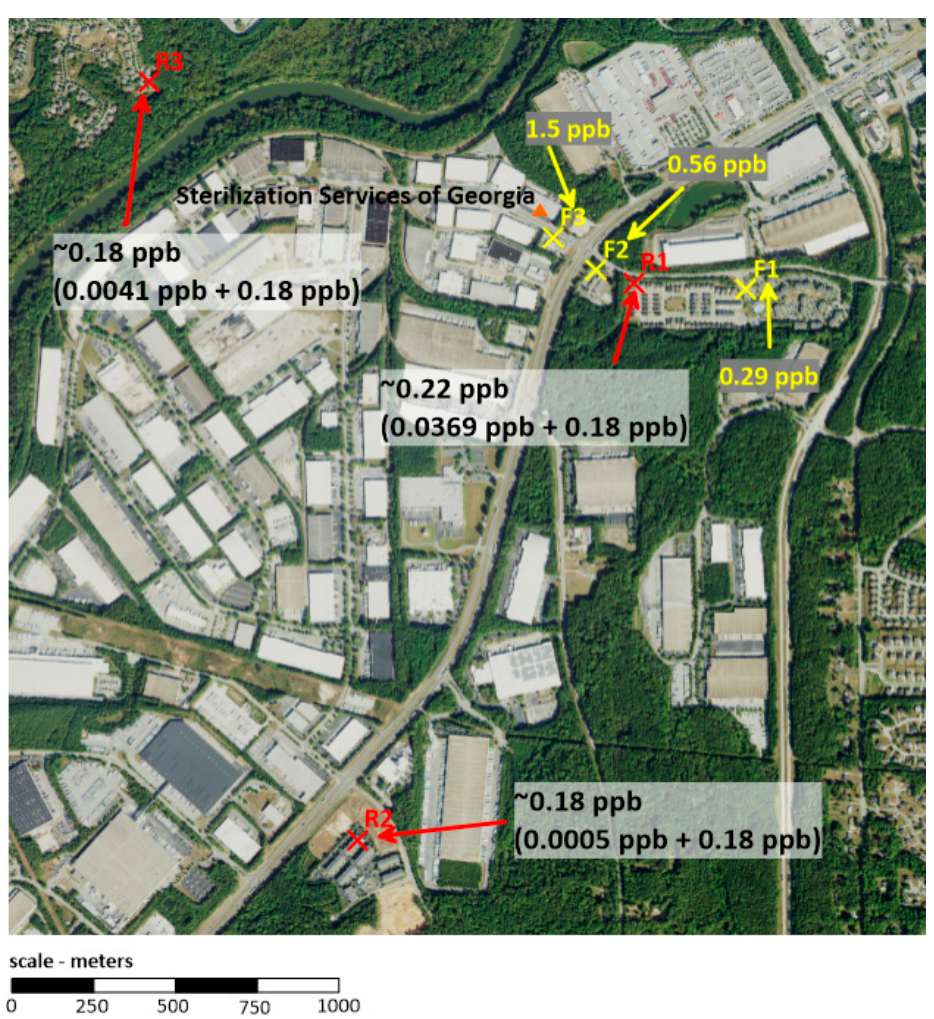
Figure 2. Adjusted EO concentrations at modeled sites (red: modeled + mean background, 0.18 ppb) and measured EO concentrations at monitored sites (yellow) around Sterilization Services (Atlanta, Georgia).